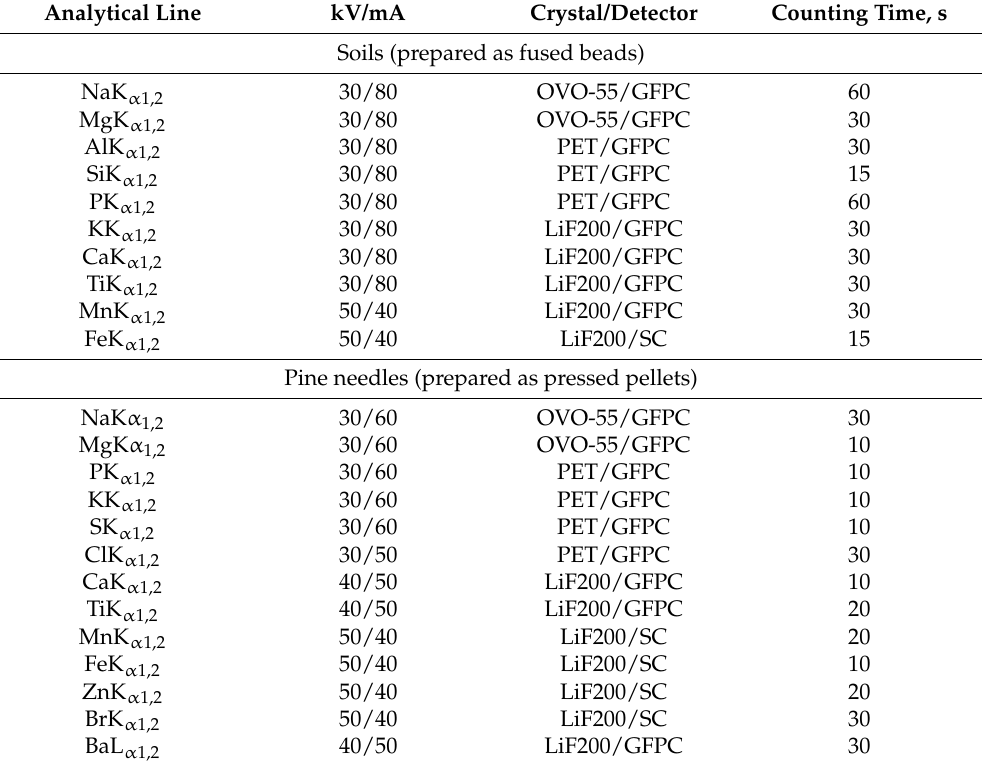
Table 1. WDXRF instrumental measurement conditions for soil and pine needle